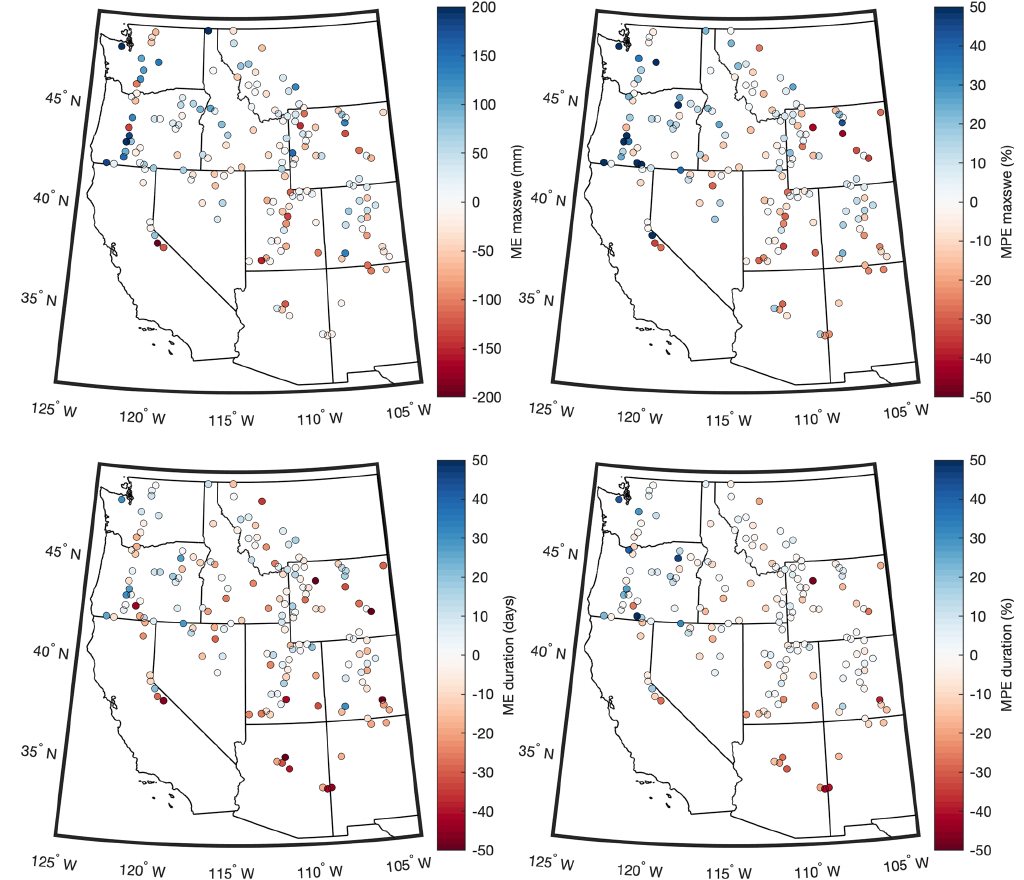
Figure 2. Performance metrics for an hourly model run with the selected parameterization.